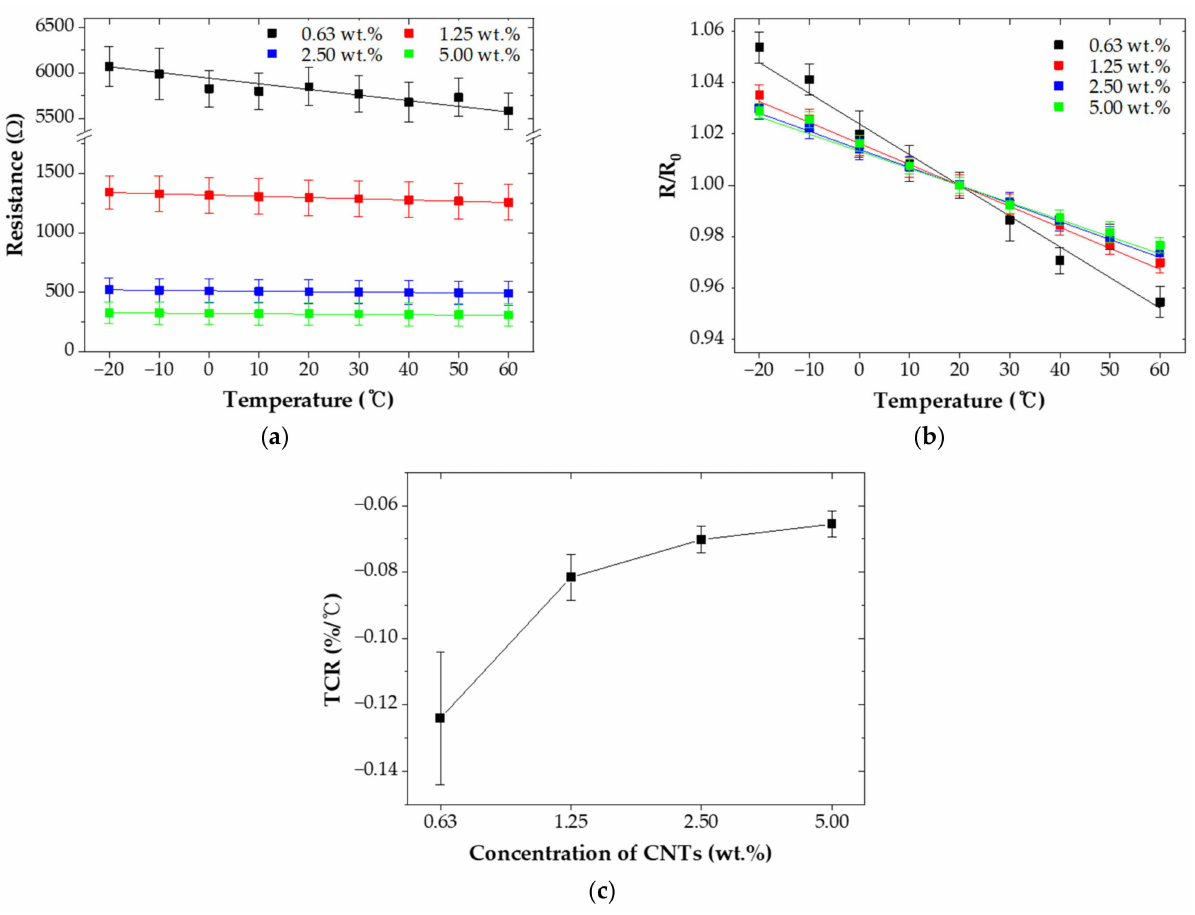
Figure 5. Temperature sensing characteristics of CNT/EP coating; ( a ) electrical resistance; ( b ) nor- malized resistance; ( c )